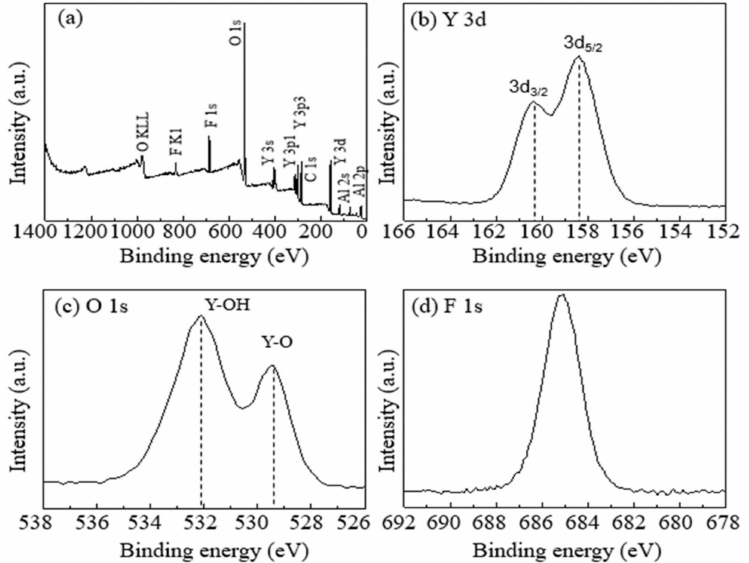
Figure 7. X-ray photoelectron spectroscopy (XPS) analysis of the coating layer: ( a ) surface survey, high-resolution of ( b ) Y 3d, ( c ) O 1s, and ( d ) F 1s